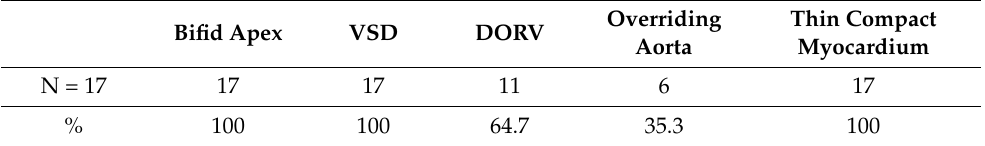
Table 3. Congenital heart defects in Rac1 Nkx2.5 mice (E14.5—P0).